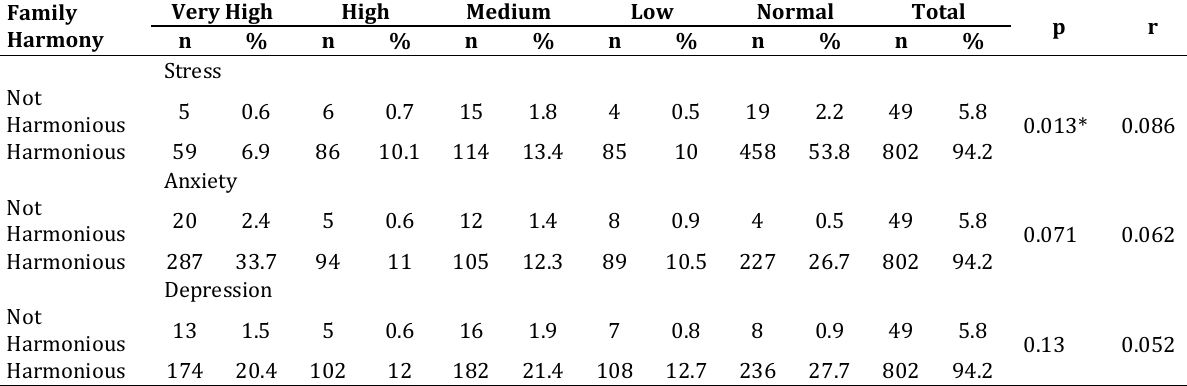
Table 2. The Relationship between Stress, Anxiety, and Depression Levels with Family Harmony Family